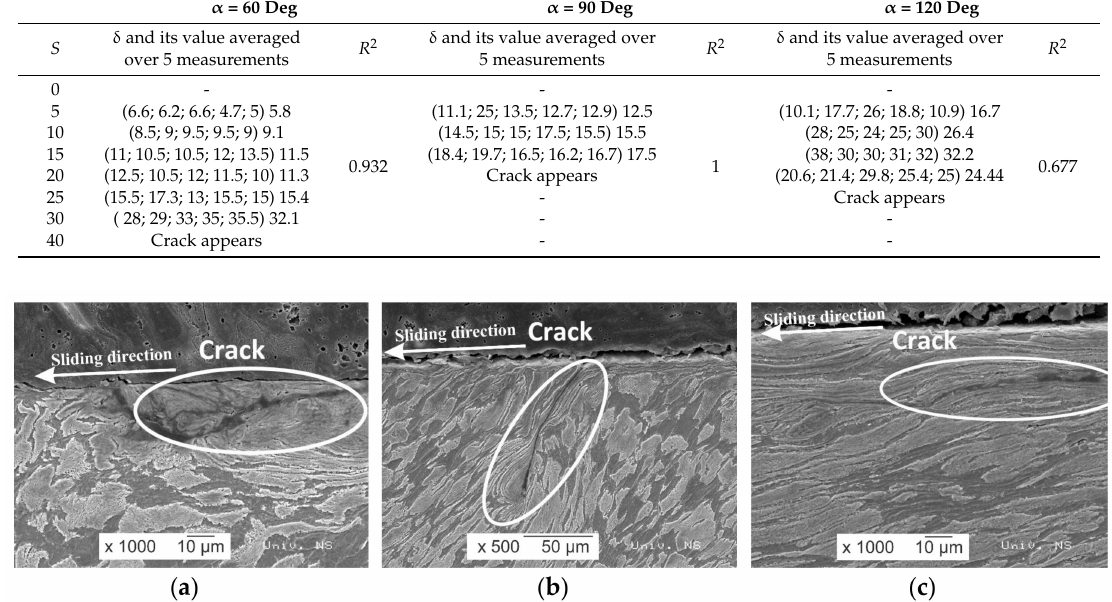
Figure 6. Appearance of cracks in upsetting with ( a ) the α = 60 deg die at S = 40 mm, ( b ) the α = 90 deg die at S = 20 mm and ( c ) the α = 120 deg die at S = 25 mm.